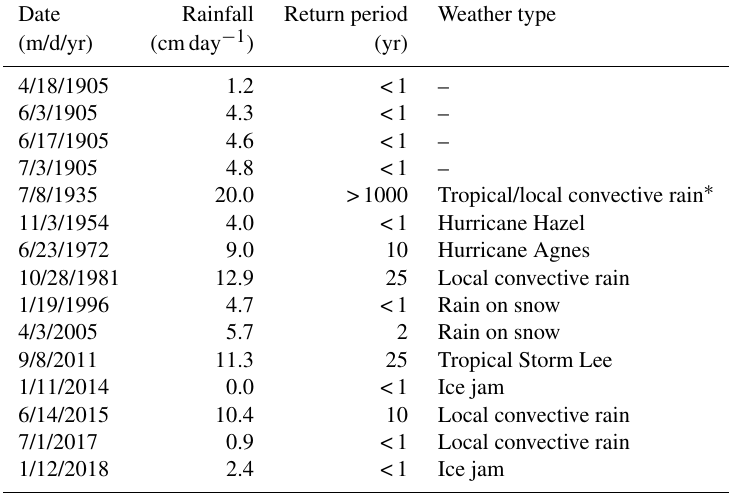
Table 1. Reported historical flooding events. Rainfall totals are the maximum daily precipitation (NCDC, 2018). Return periods are deter- mined from NOAA Atlas 14 (Percia et al., 2015).